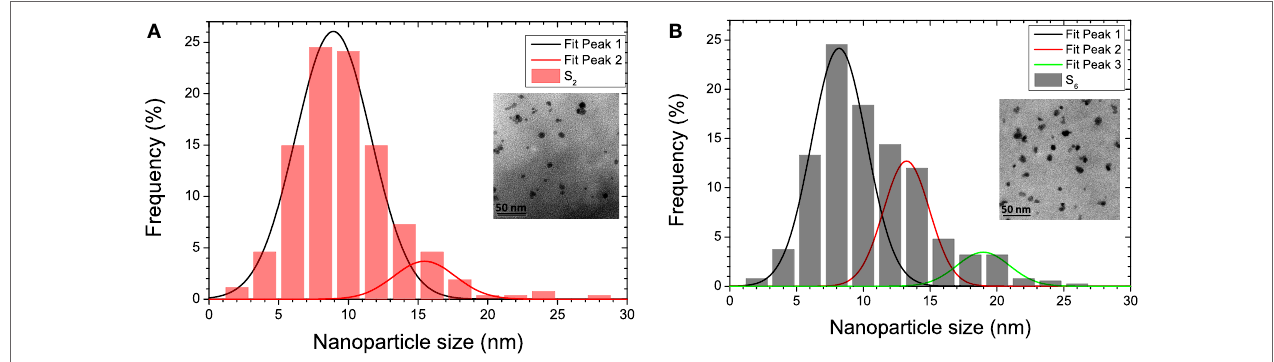
FigUre 2 | nanoparticle size distribution by transmission electron microscopy (TeM) image analysis and gaussian fitting for (a) 3.5% (s 2 ) and (B) 24.6% (s 6 ) M-sre . Inset in each figure corresponds to TEM images.